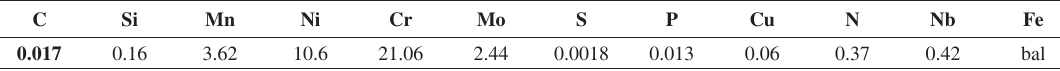
Table 1. Chemical composition of the Austenitic Stainless Steel ISO 5832-9 (mass %).